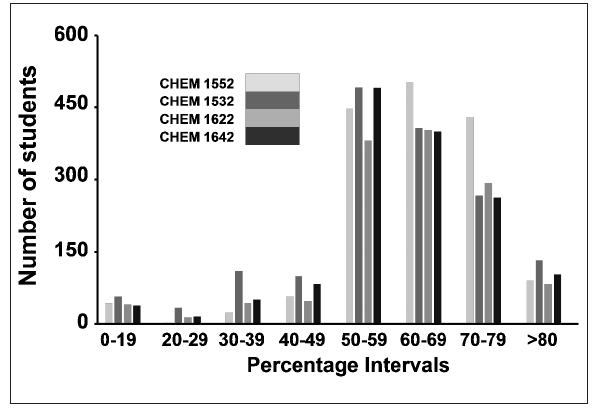
Performance of Extended BSc students in the